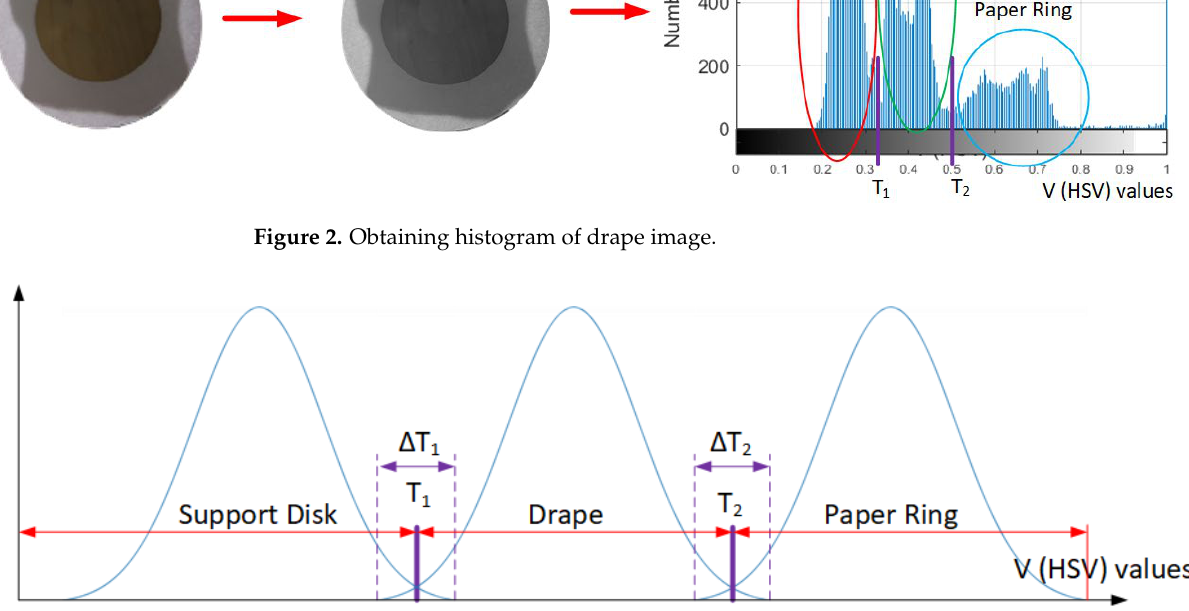
Figure 3. Determination of threshold values.